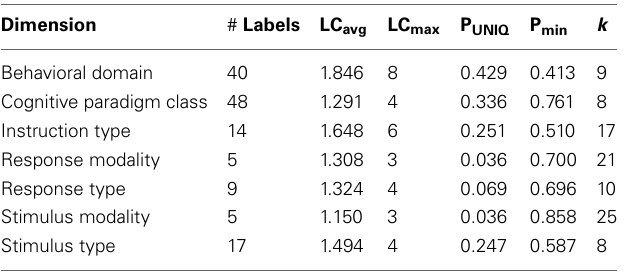
Table 1 | Characteristics of the data by dimension of the CogPO ontology and label